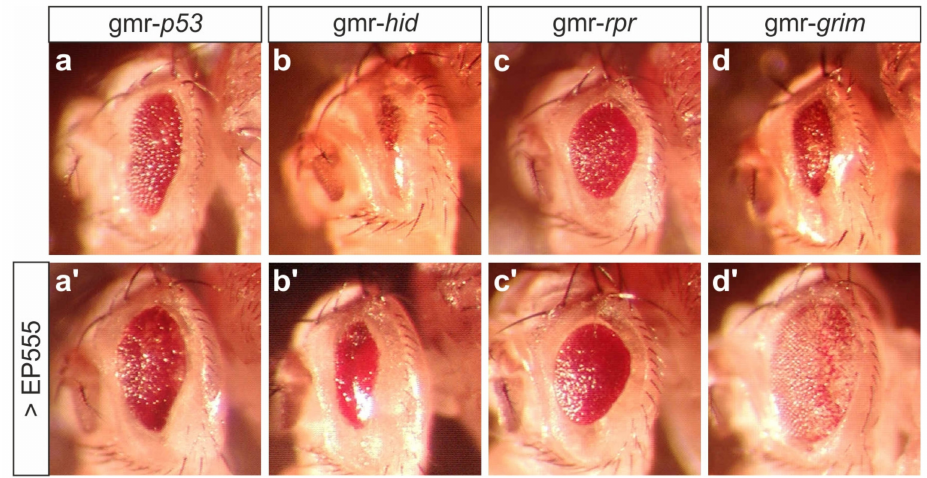
Figure 3. EP555 attenuates pro-apoptotic gene activity. ( a – d’ ) Overexpression of the indicated genes during eye development, induced with gmr-Gal4. Female heads are shown. Note increased eye size in combination with EP555. Genotypes: gmr- p53 /+ ( a ), EP555/gmr- p53 ; gmr-Gal4/+ ( a’ ), gmr- hid /+ ( b ), EP555/+; gmr- hid /gmr-Gal4 ( b’ ), gmr- rpr /+ ( c ), EP555/+; gmr-Gal4/+; gmr- rpr /+ ( c’ ), gmr- grim /+ ( d ), EP555/+; gmr-Gal4/+; gmr- grim /+ ( d’